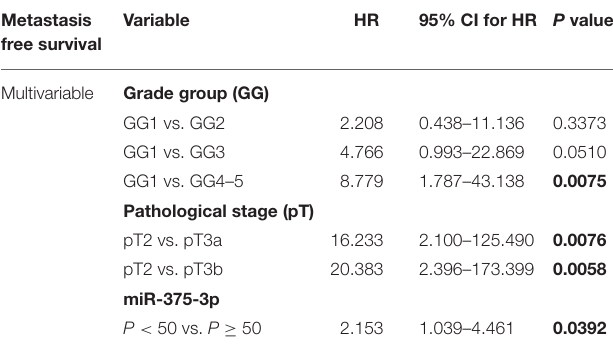
TABLE 4 | Cox regression models assessing the potential of clinical variables and circulating miRs levels in the prediction of metastasis free survival (Cohort #2). Metastasis Variable HR 95% CI for HR P value free survival